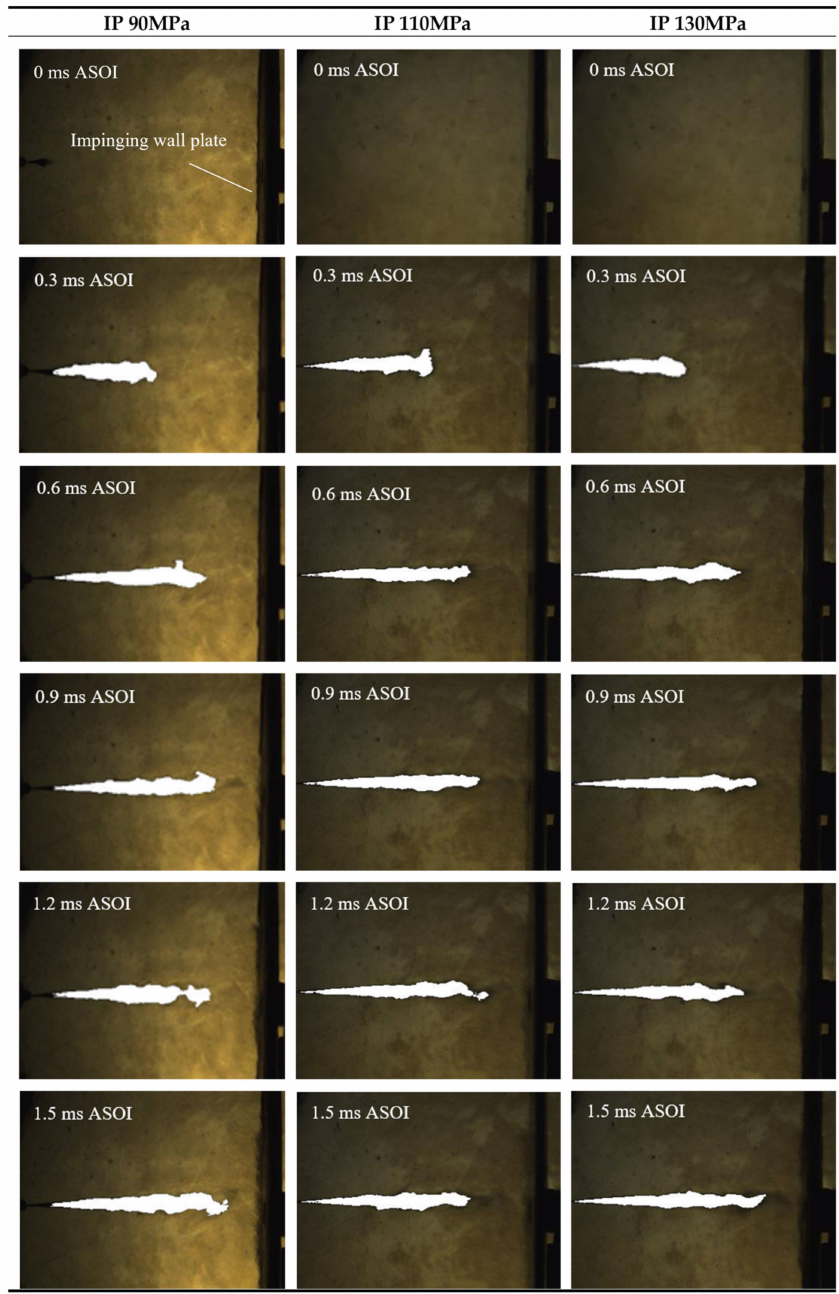
Figure 5. Spray images under di ff erent injection